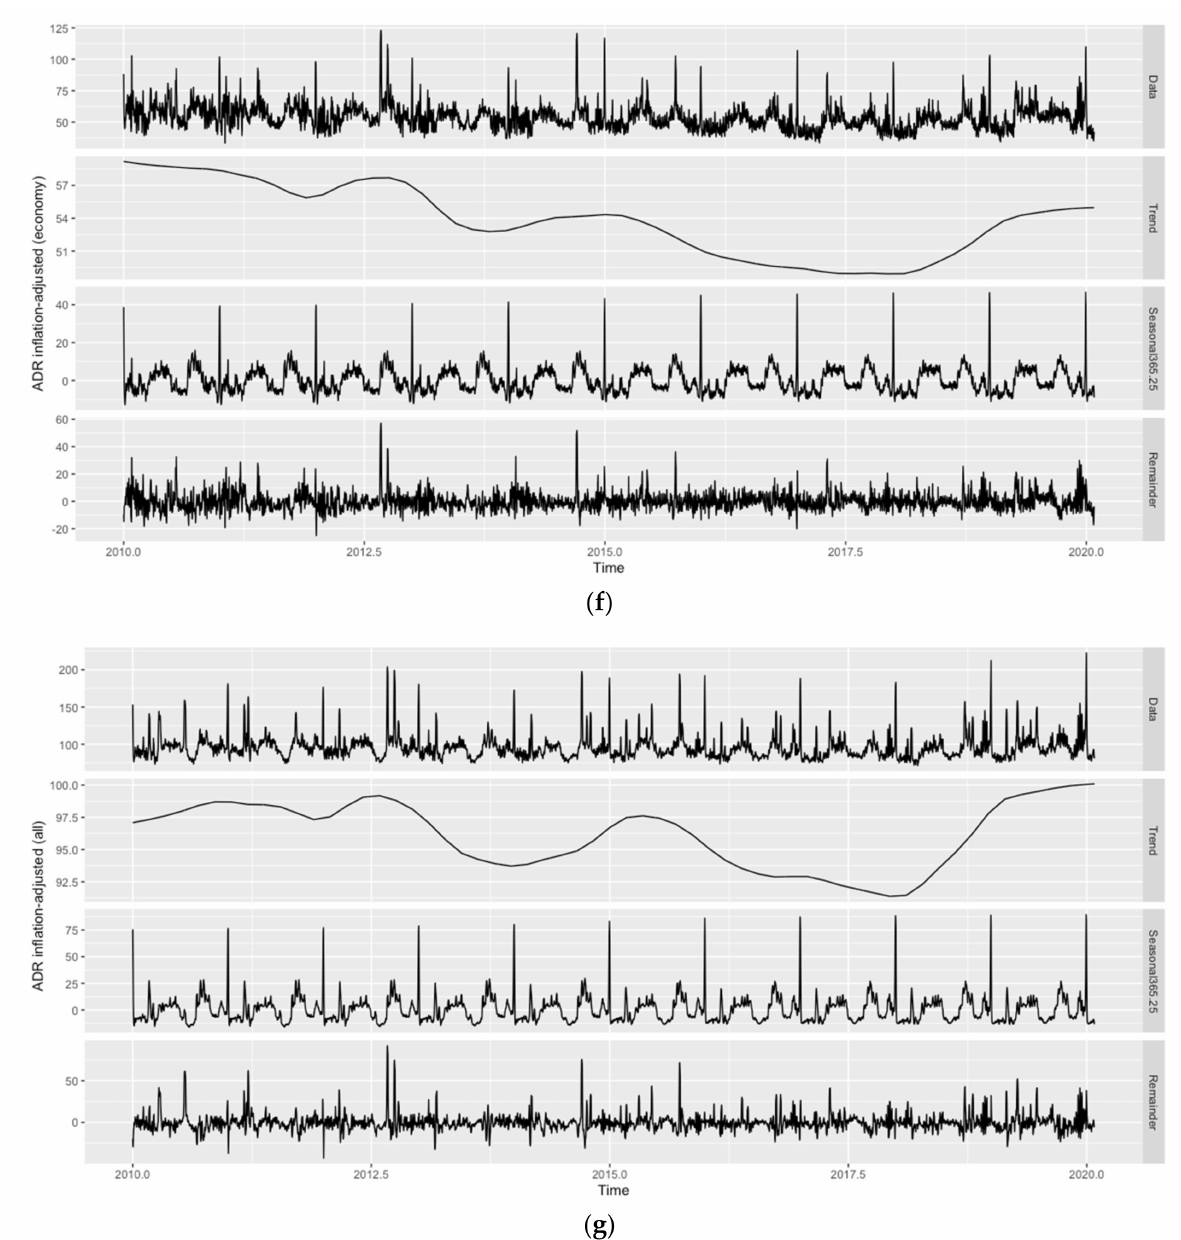
Figure 2. Evolution and STL decomposition of inflation-adjusted ADR in Vienna. Hotel classes from top to bottom: ( a ) ‘luxury’, ( b ) ‘upper upscale’, ( c ) ‘upscale’, ( d ) ‘upper midscale’, ( e ) ‘midscale’, ( f ) ‘economy’, and ( g ) ‘all’. Source: STR SHARE Center, own illustration using